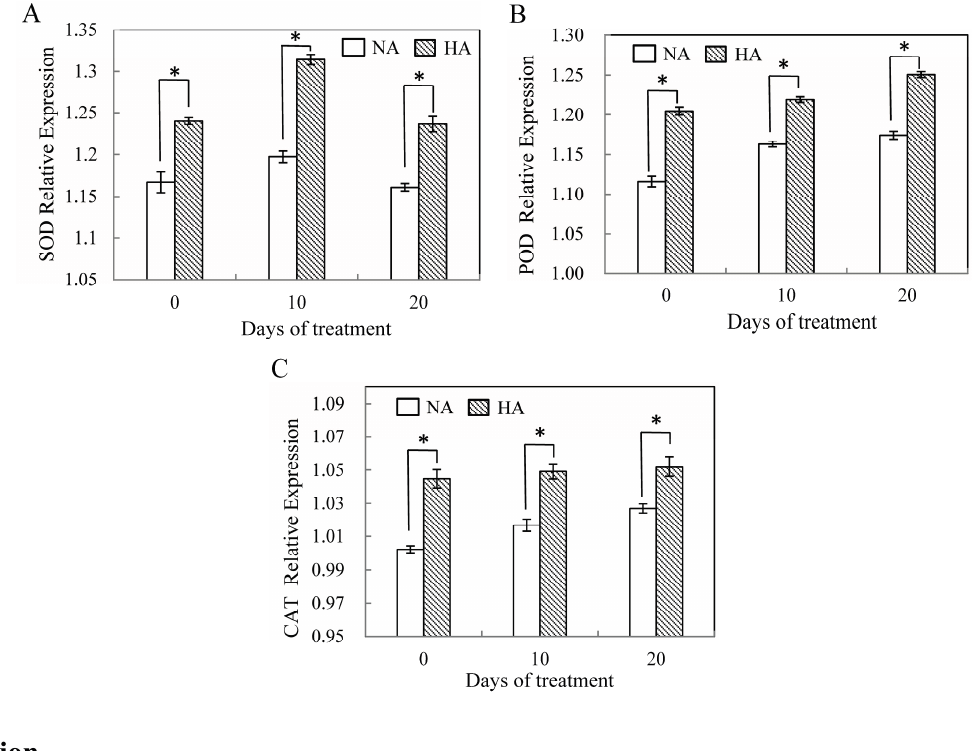
Figure 4. The relative expression level of SOD ( A ), POD ( B ) and CAT ( C ) in leaves of heat-acclimated (HA) and non-acclimated (NA) plants as affected by high temperature. Error bars represent standard error of the mean. Asterisks above columns indicate a significant treatment differences between HA and NA. LSD ( p ≤